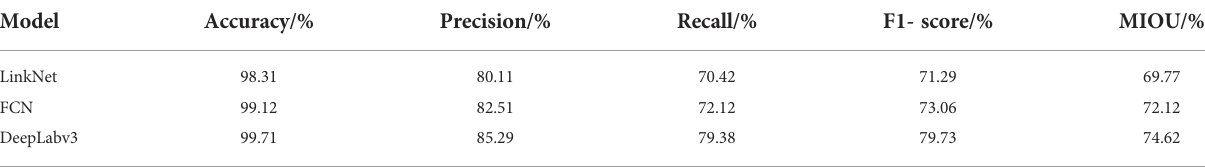
TABLE 2 Evaluation of different models in segmenting residual from UAV fi lm images.